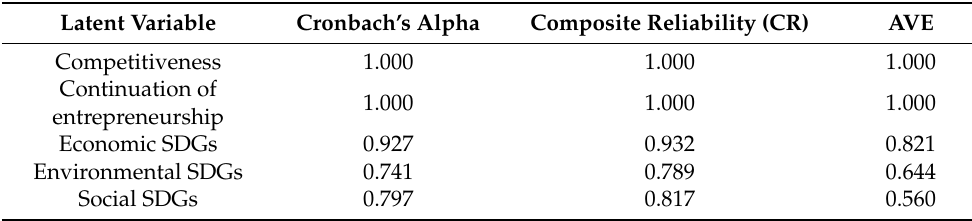
Table 1. Internal Consistency, Reliability and Convergence